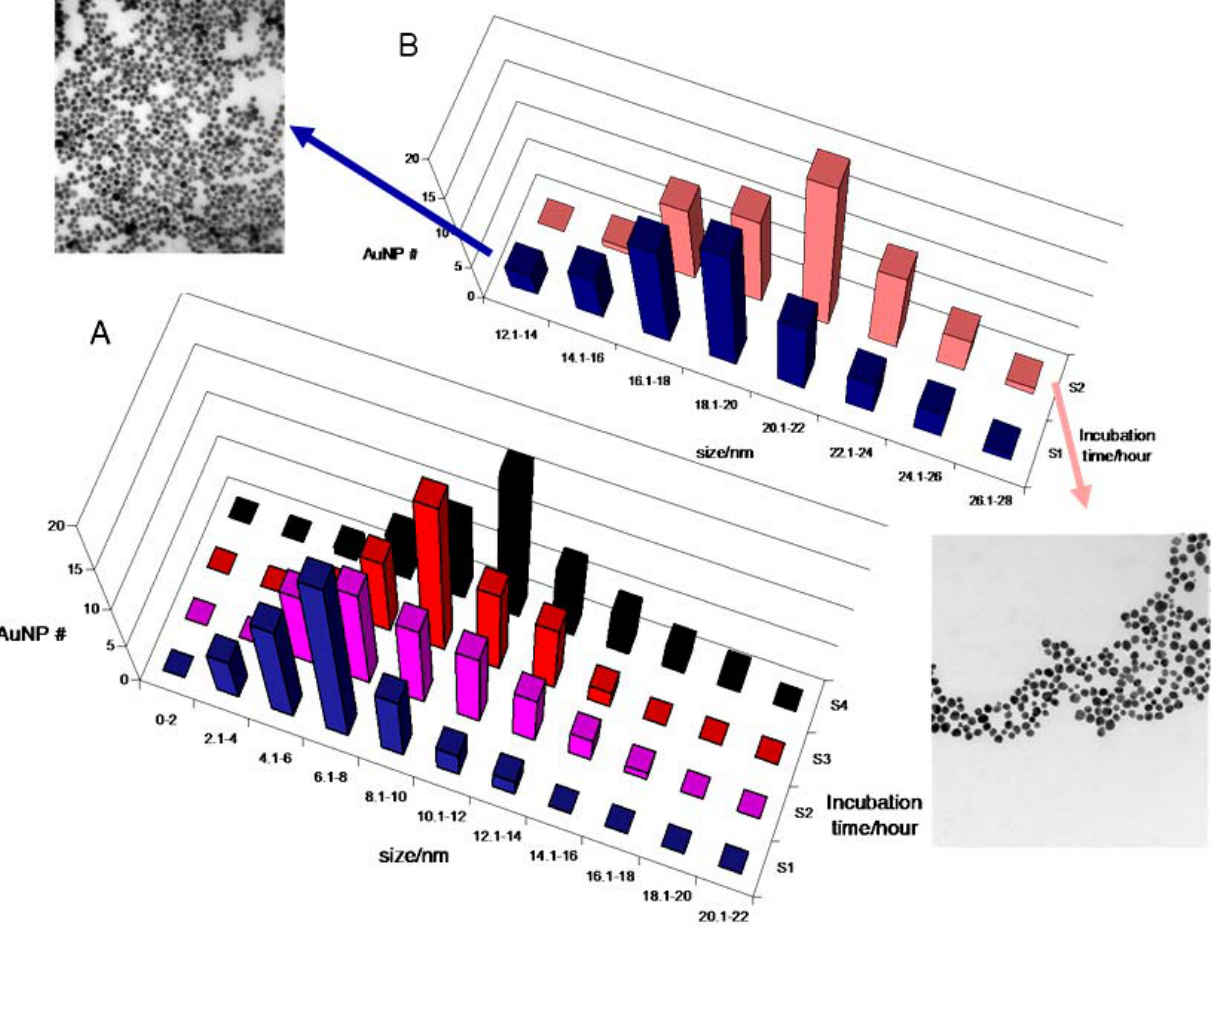
Figure 5. ( A ) Histogram of Au NP size distributions corresponding to samples incubated with plasmid DNA in TE buffer for 1 h (S1, blue), 2 h (S2, purple), 4 h (S3, red), and 7 h (S4, black). After 4 h there is a progressive narrowing of the distribution and an increase in particle size that is in agreement with the red shifts observed in the UV-visible spectra (Figures 1 and 2). ( B ) Histogram of Au NP sizes corresponding to samples incubated with plasmid DNA for 12 h (S1, dark blue) and 15 h (S2, pink). TEM images of the Au NP from 12 h (dark blue) and 15 h (pink) incubations at 70